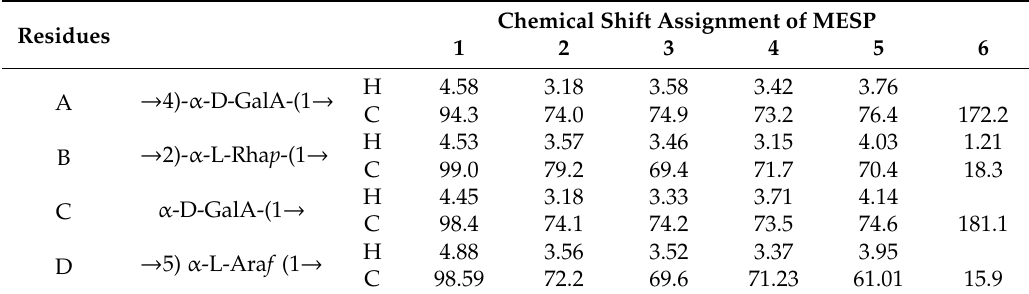
Table 2. Summary of 1 H and 13 C chemical shifts for